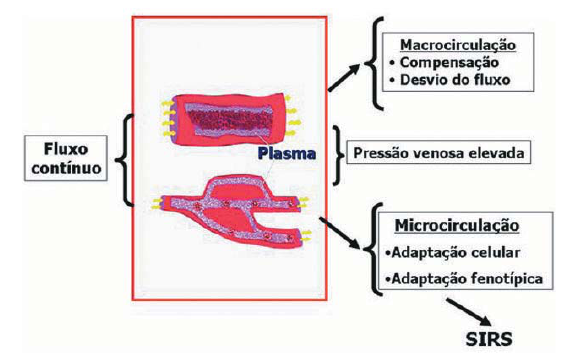
Fig. 2 - Microcirculação na circulação extracorpórea